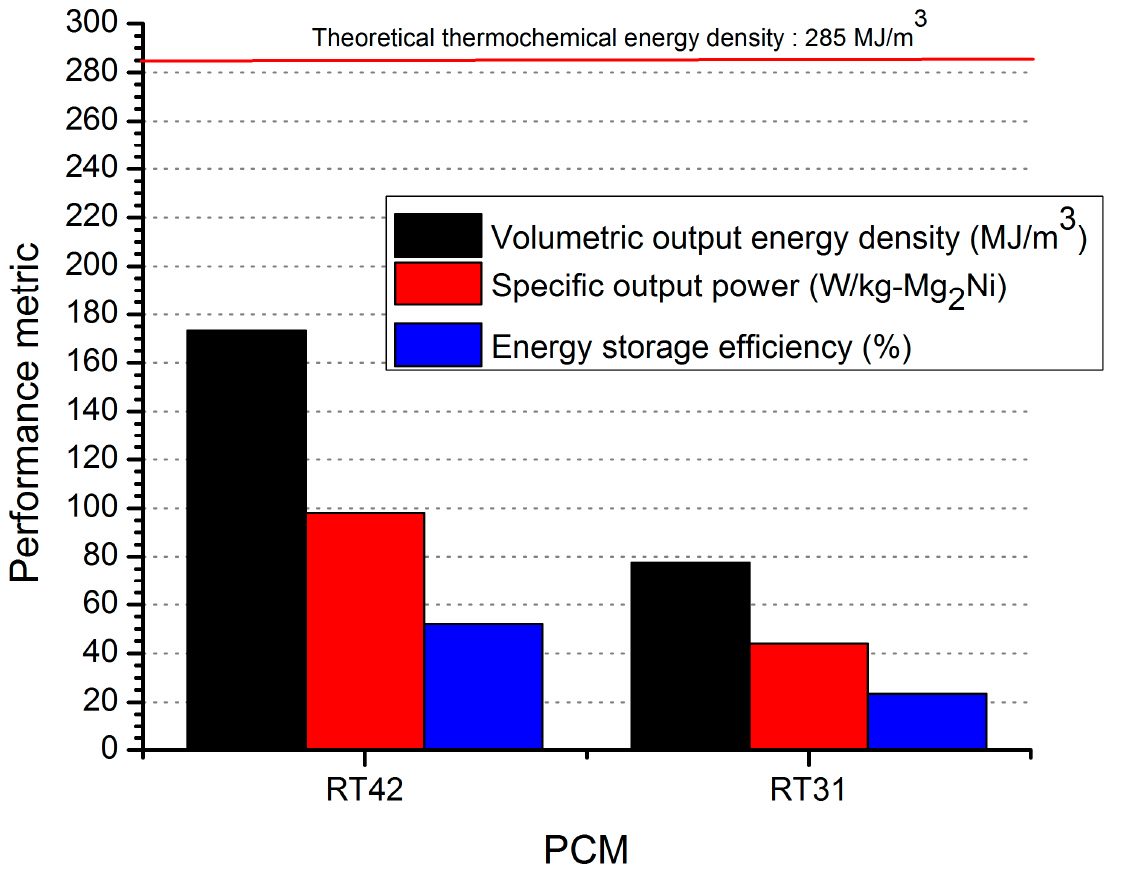
Figure 11. The influence of the PCM melting point on the performance of heat storage system: energy density and specific power output, energy storage efficiency.